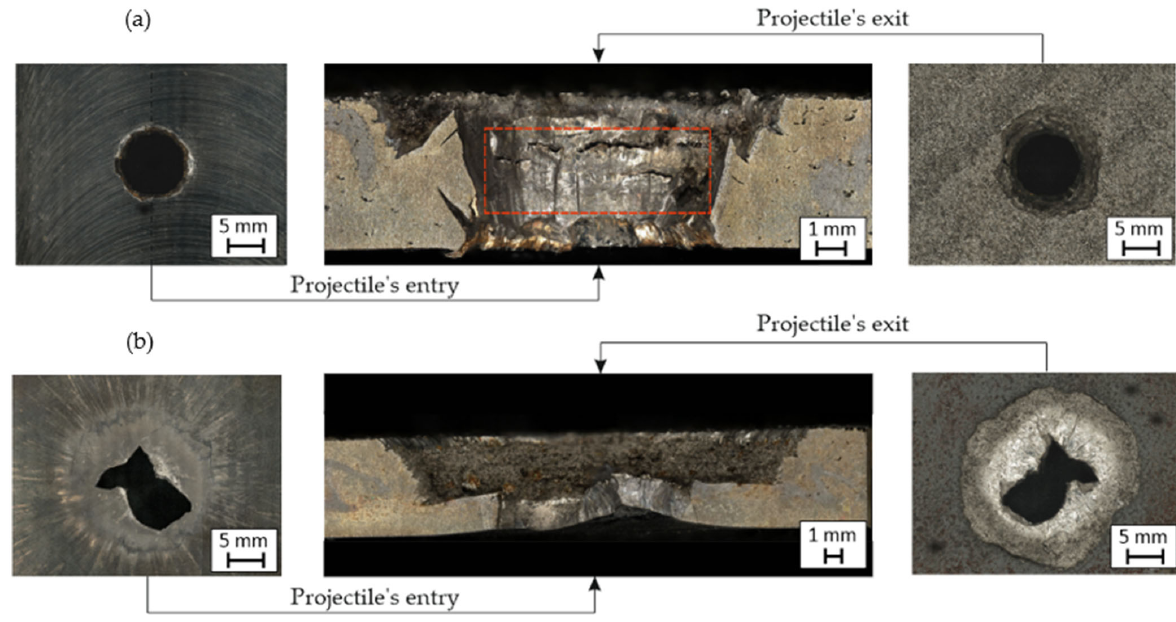
Figure 13. Fractures of projectile entry and exit of both penetrated plates: ( a ) BHT ( b ) AHT.